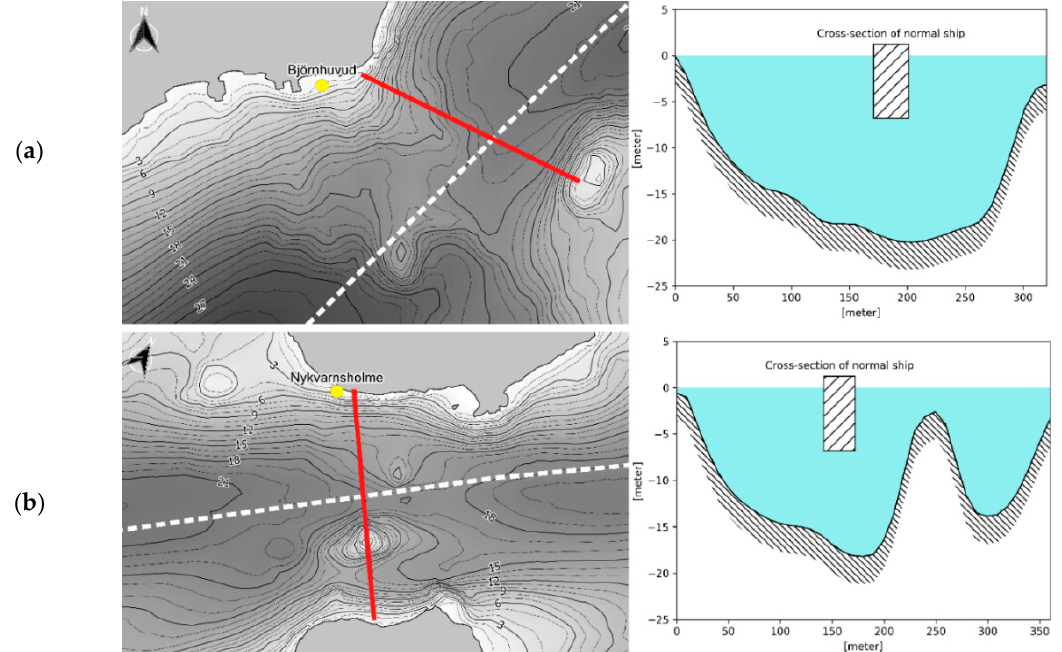
Figure 4. Bathymetry at Björnhuvud ( a ) and Nykvarnsholme ( b ) together with the smallest cross section in the fairway shown with a red line. The center line of the fairway is marked with a dashed white line. The profile of the smallest cross section for each location is shown to the right (note that a distorted scale is used). The yellow marks indicate the location of the measuring station.